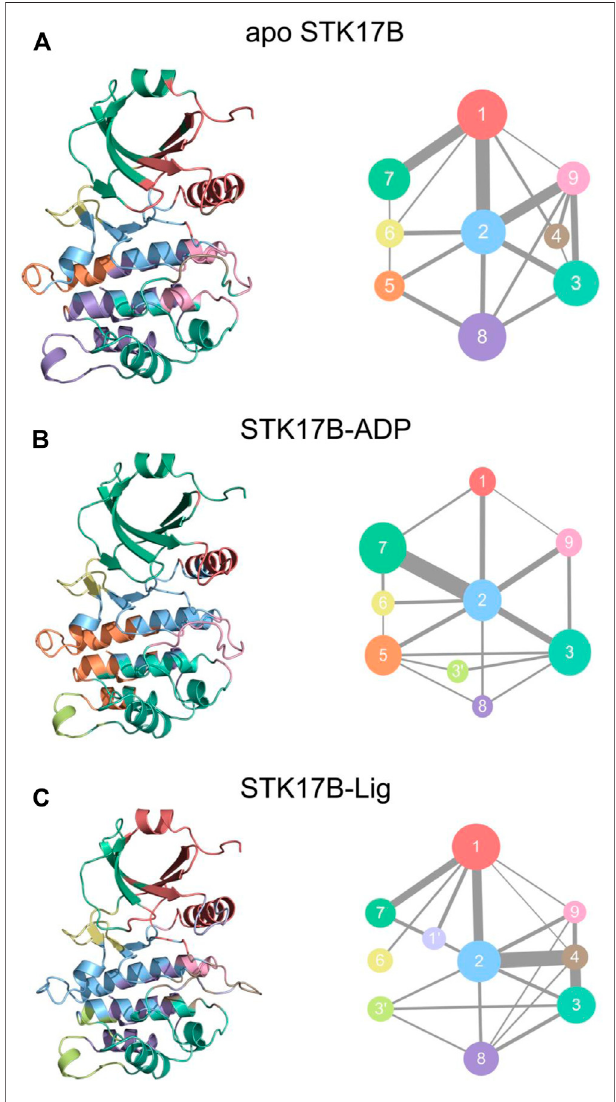
FIGURE 7 | The community networks for the apo (A) , ADP-bound (B) , and ligand-bound (C) systems. The communities are shown as circles with different colors. The edges represent the connections among communities and the width is related to the intensity of the connections among